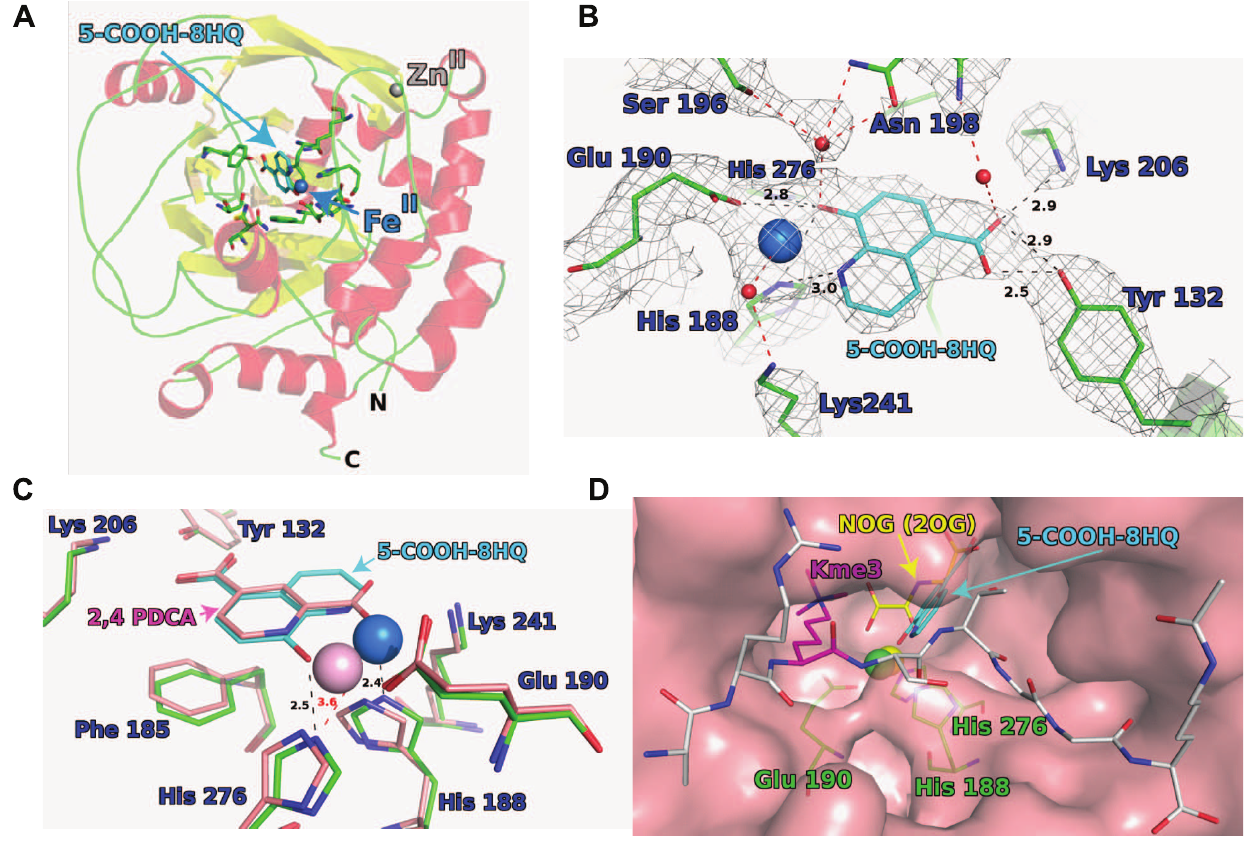
Figure 4. JMJD2A crystal structure complexed with 5-carboxy-8-HQ (SID 85736331). ( A ) active siteresidues are ingreen sticks, 5-carboxy-8- hydroxyquinoline as cyan sticks, secondary structure helices in red and sheets in yellow. The Ni(II) ion (replacing Fe(II)), is a blue sphere and the Zn(II) is a grey sphere. ( B ) Binding mode of 5-carboxy-8-hydroxyquinoline in JMJD2A. The experimental 2Fo-Fc electron density is shown as grey mesh (contoured at 1 s ). Hydrogen bonds to residues are shown in black. Hydrogen bonds involving waters (red spheres) are shown in red, distances in A˚. ( C ) Overlay of JMJD2A crystal structure with the 5-carboxy-8-hydroxyquinoline (residues green, compound cyan, Ni(II) in blue) with the crystal structure with 2,4 PDCA (residues compound and Ni(II) ion are pink, PDB ID: 2VD7). The distances shown are for the 8-hydroxyquinoline structure between: 5-carboxy-8- hydroxyquinoline and His 276, Ni 2 + and His 188 (in black), His 276 and Ni 2 + (in red). Distances in A˚. ( D ) Surface view of superimposition of 8- hydroxyquinoline 5-acid bound JMJD2A structure with that of JMJD2A bound to histone 3 lysine 9 trimethylated (H3K9me3) substrate peptide (grey and magenta sticks) and the 2-oxoglutarate (2OG) mimetic N -oxalylglycine (NOG, yellow sticks), PDB ID: 2OQ6. Binding of the 8-hydroxyquinoline 5-acid (cyan sticks) is likely to prevent binding of 2OG but not directly that of the H3K9me3 residue (in magenta) or other residues in the substrate peptide (in grey). Peptide sequence ARK(me3)STGGK(Ac). Ni 2 + of structure 2OQ6, yellow sphere; Ni 2 + of 8-hydroxyquinoline structure, green sphere. The triad of metal coordinating residues are in green sticks. Crystallographic data and refinement parameters are described in Table S2